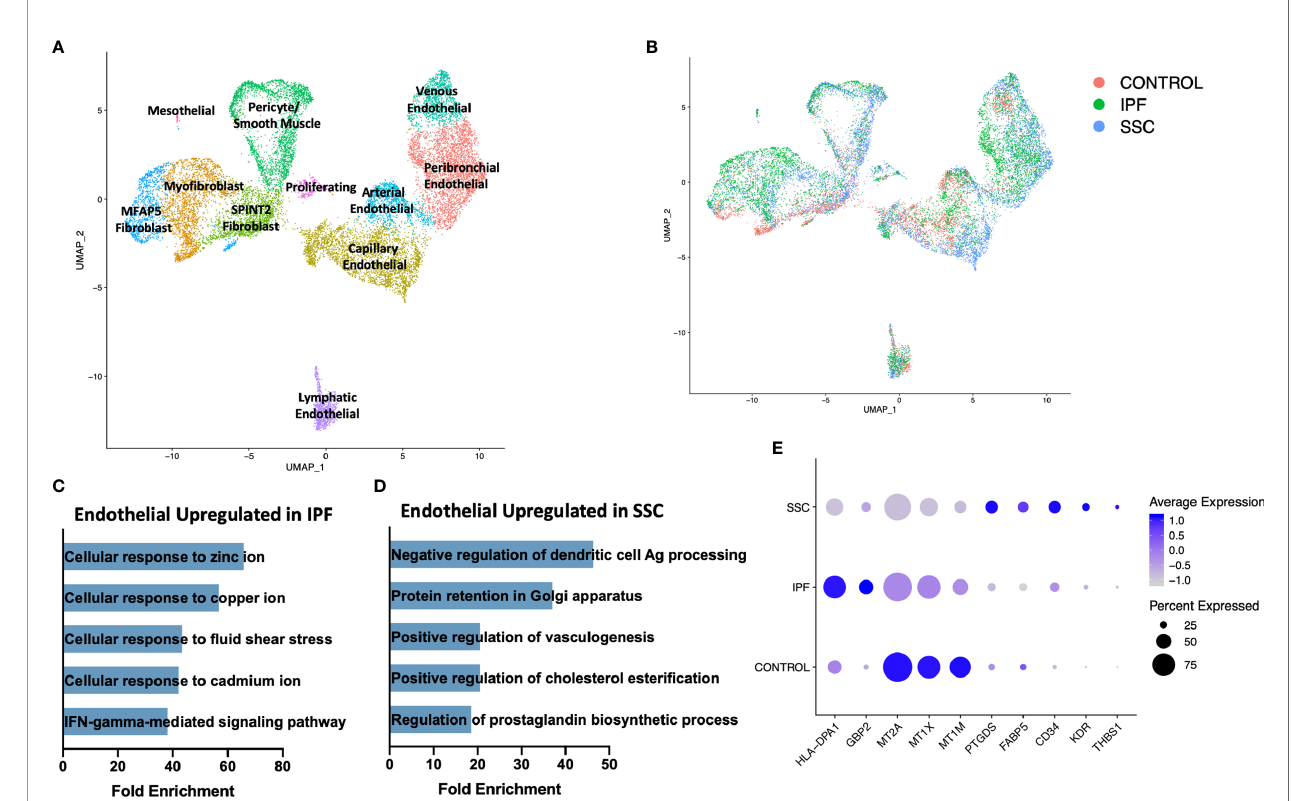
FIGURE 7 | ScRNA-seq analysis of IPF, SSc-ILD, and control stromal cell populations. (A) UMAP plot of stromal cell populations, identi fi ed by cell type. (B) UMAP plot of stromal cell populations, identi fi ed by disease status. (C) Pathways upregulated in IPF endothelial cells compared to SSc-ILD endothelial cells (D) Pathways upregulated in SSc-ILD endothelial cells compared to IPF endothelial cells (E) Expression of selected genes in all non-lymphatic endothelial cells, separated by disease state. scRNA-seq, single-cell RNA-sequencing; IPF, idiopathic pulmonary fi brosis; SSc-ILD, systemic sclerosis-associated interstitial lung disease; UMAP, uniform manifold approximation and